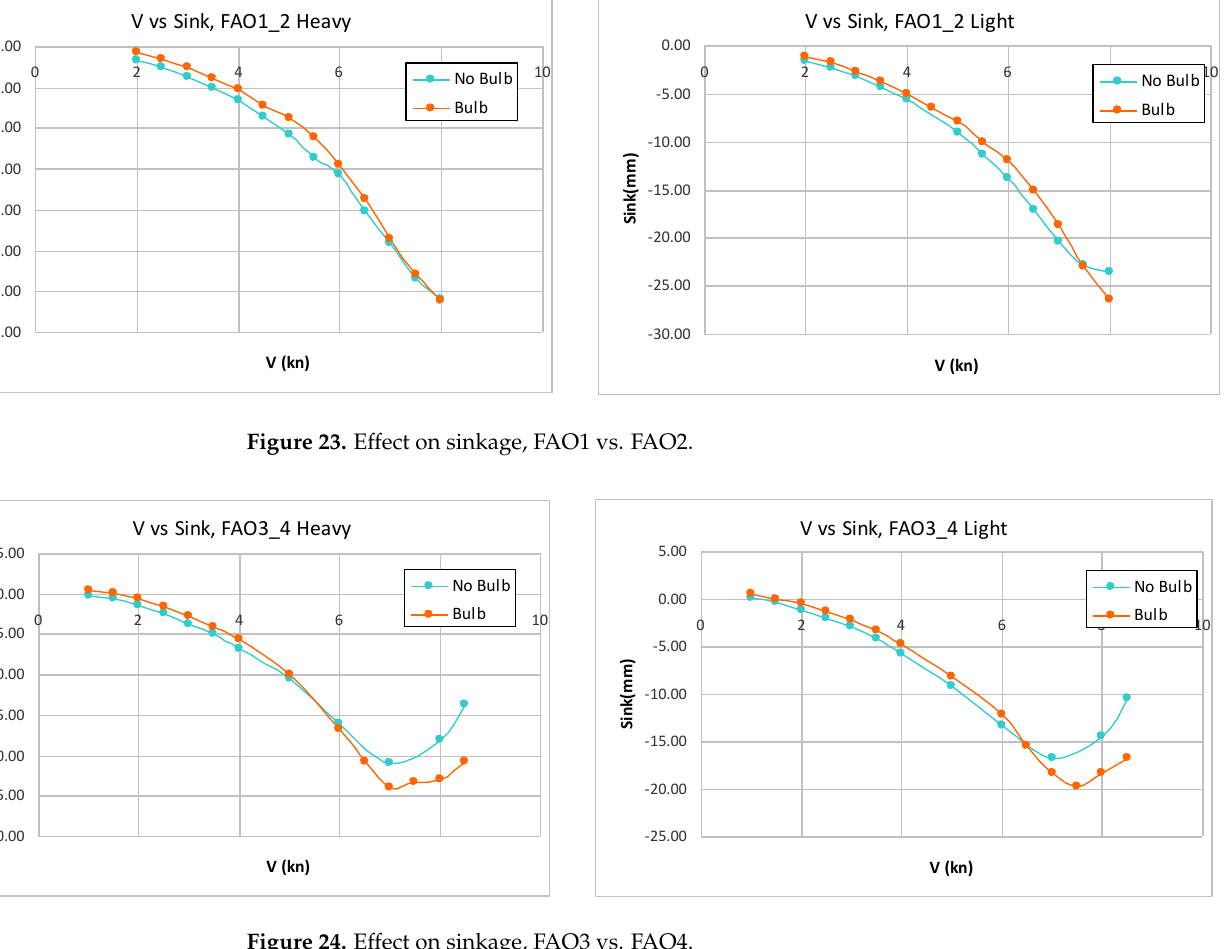
Figure 24. Effect on sinkage, FAO3 vs. FAO4.